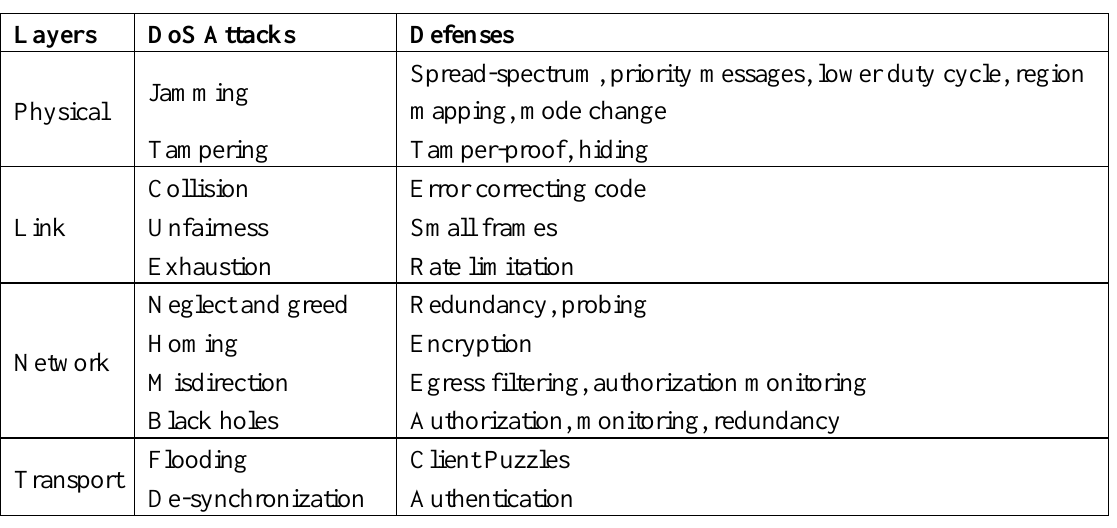
Table 1. WBAN OSI layers and DoS